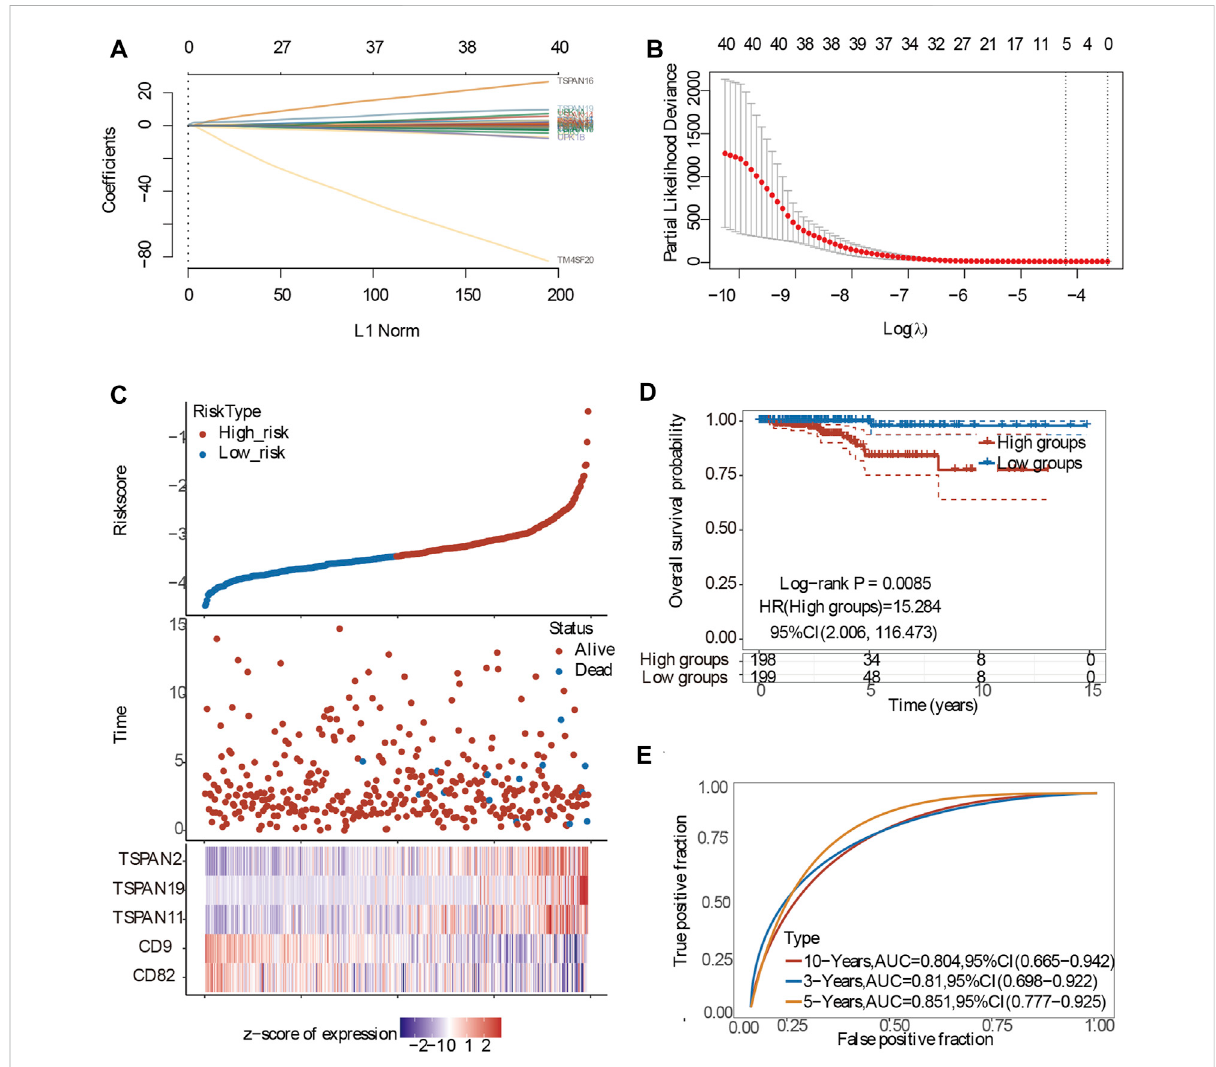
FIGURE 9 Construction of the prognostic model of PTC patients. (A) Processes of LASSO Cox model fi tting. Each curve represents a gene. The trend of each coef fi cient against the L1-norm is plotted when λ changes. L1-norm is the total absolute of non-zero coef fi cients. LASSO, least absolute shrinkage and selection operator; (B) λ selection by 10-fold cross-validation. Continuous upright lines are partial likelihood deviance ±SE; dotted lines are depicted at the optimal values by minimum criteria (lambda.min, left vertical dotted line) and 1-SE criteria (lambda.1se, right vertical dotted line). The partial likelihood deviance with changing of log ( λ ) was plotted. (C) The risk scores distribution, survival status, and gene expression patterns of patients in high and low-risk groups; (D) The risk score and best cut-off value of model; (E) The AUCs for 3-year,5-year and 10-year